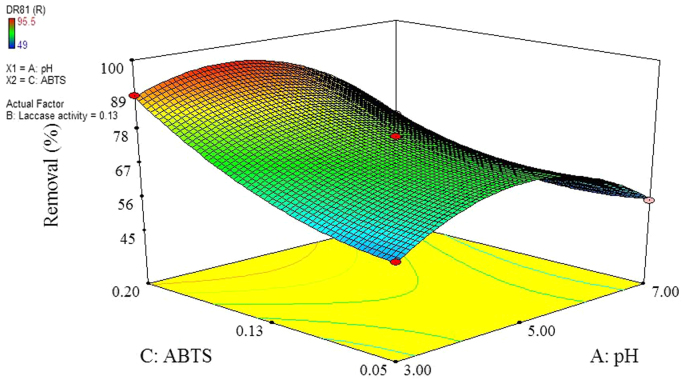
3D surface plot from BBD showing the interaction effects of pH and ABTS on elimination of DR81.